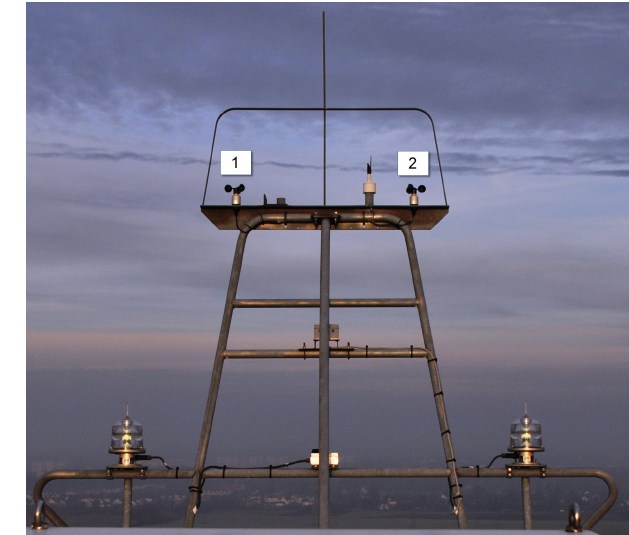
Figure 7. Typical layout of a nacelle-mounted met mast. Light- ning rod, two cup anemometers (1 + 2), one wind vane and aviation lights.